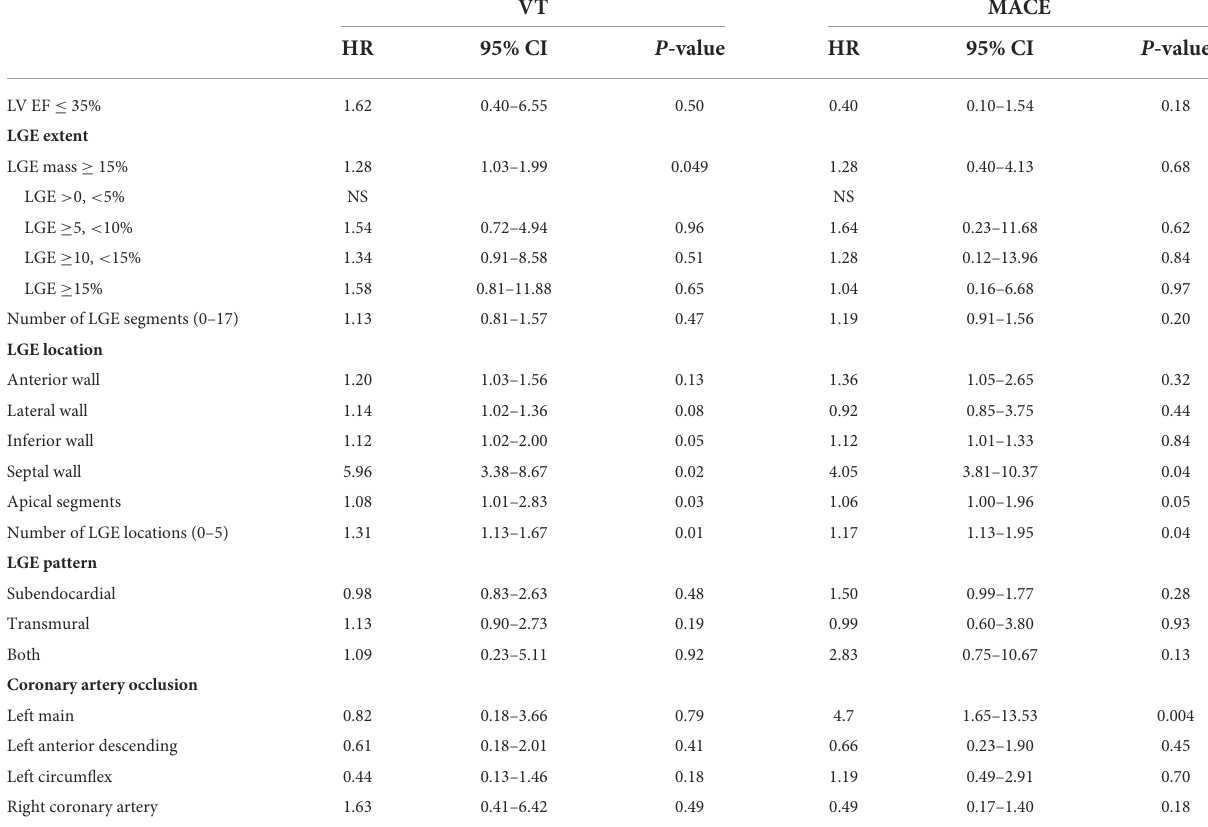
TABLE 5 Predictors for primary and secondary outcomes with patients with ICM on multivariate analysis adjusted for age, sex, and BMI. VT MACE HR 95% CI P -value HR 95% CI P